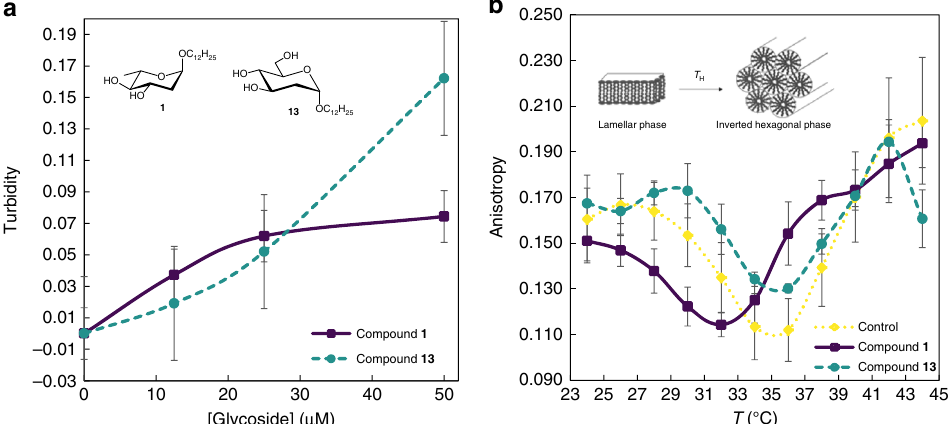
Fig. 6 Glycoside-membrane interactions and induction of hexagonal phases. a Turbidity increase upon addition of compounds 1 and 13 to LUVs of POPE at 35 °C. Results are given as a quotient between the absorbance of LUVs in the presence of glycoside minus its intrinsic absorbance ( A – B ) and the absorbance of LUVs in the presence of ethanol ( A 0 ), thus expressing exclusively the changes in turbidity of LUVs caused by their interaction with glycosides. Results are expressed as mean ± SE ( n = 3). b Steady-state fl uorescence anisotropy of TMA-DPH in binary mixtures of POPE/Soy:PE 3:1 in the presence or absence of compounds 1 and 13 (50 μ M). Each dot represents the mean of three replicates for control and compound 1 and fi ve replicates for compound 13 , expressed as mean ±